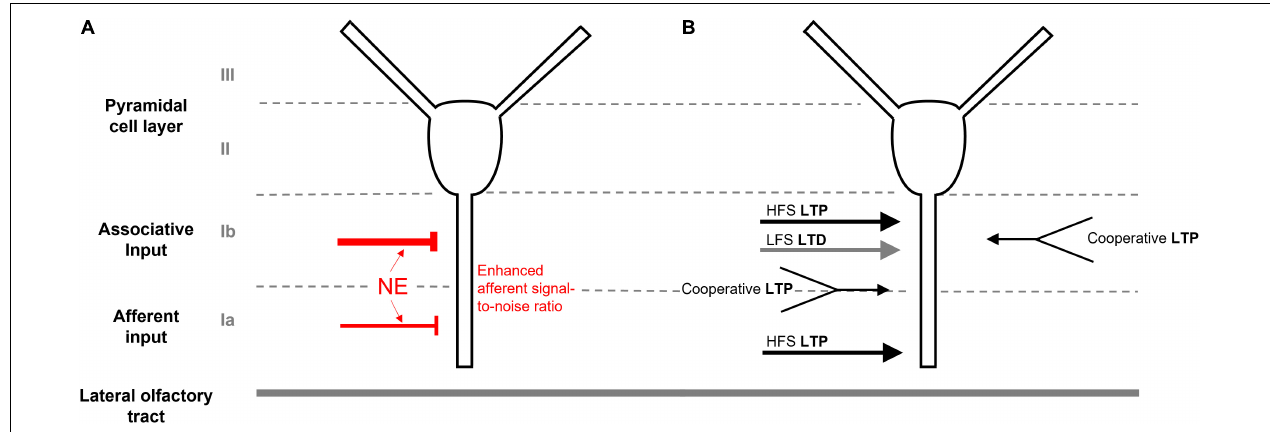
FIGURE 1 | Anatomy and synaptic plasticity of the piriform cortex. (A) The unique laminar cytoarchitecture of the piriform cortex, consisting of cell body layers (II/III), the associative layer (Ib) and the afferent input layer (Ia). LC-sourced NE leads to stronger inhibition of associative connections in Ib and enhanced afferent signal-to noise ratio in Ia. (B) LTP can be induced by high frequence stimulation (HFS) of either the associative or afferent layers. Weak cooperative stimulation of either separate associative connections or co-activation of both afferent and associative fibers can also induce LTP in the presence of GABAA inhibition. Low frequence stimulation (LFS) can produce LTD in